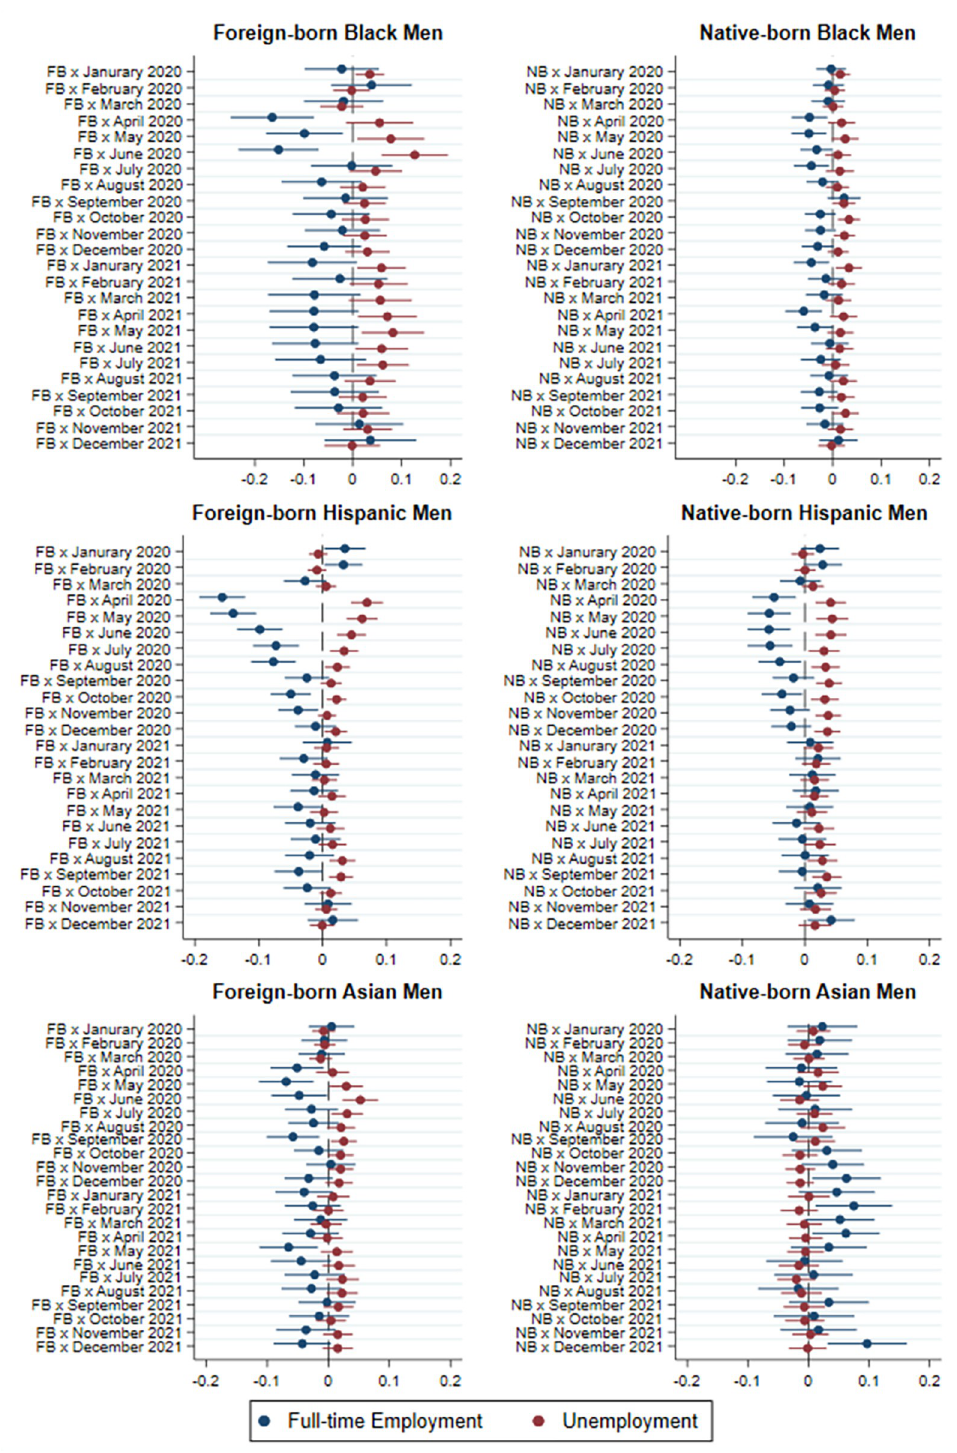
Fig 3. Difference in probability of full-time employment and unemployment between non-White and native-born White men by immigrant status and race/ethnicity, 2020–2021 relative to 2019.